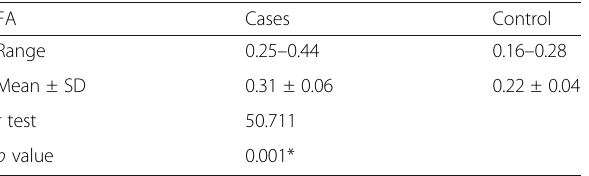
Table 4 Comparison between studied groups according to FA value of optic chiasm ( n = 50) FA Cases